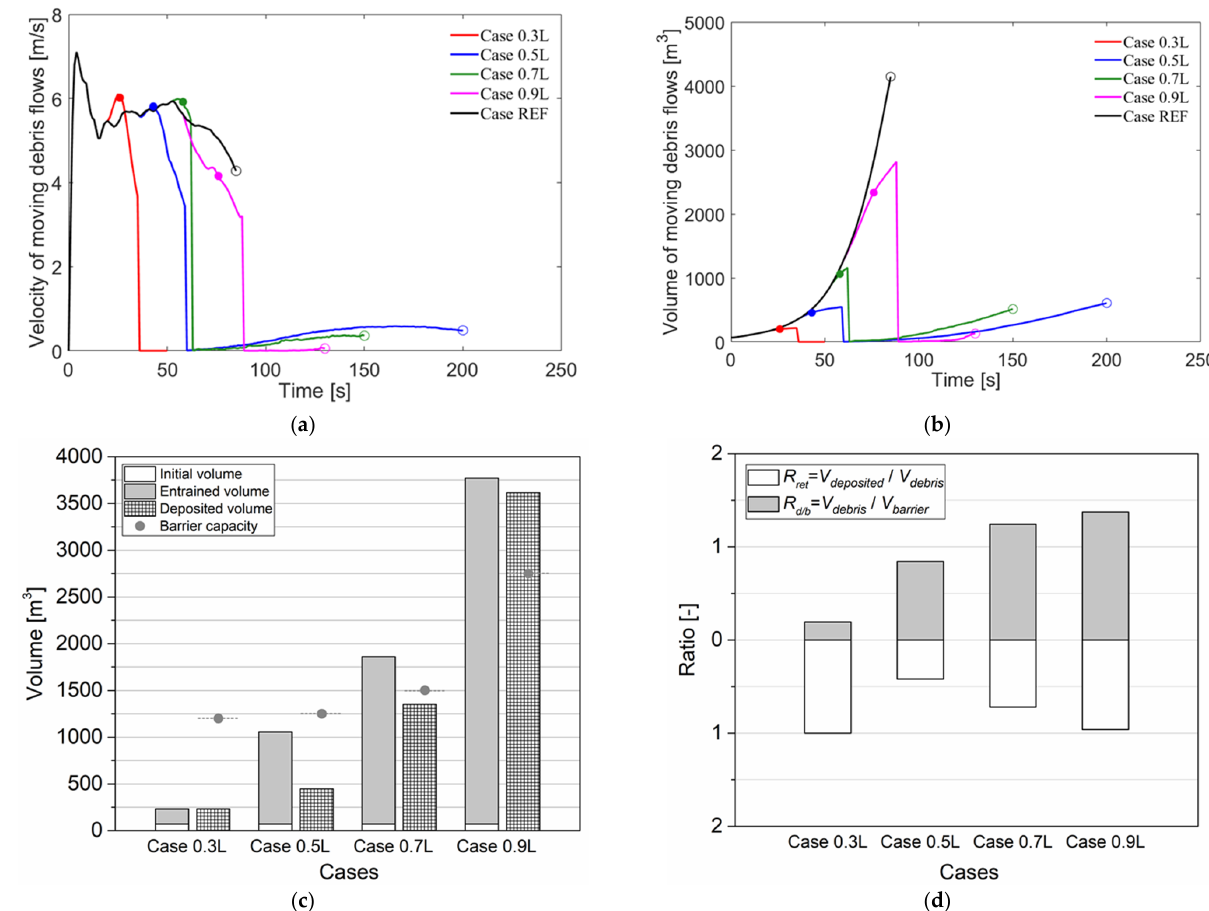
Figure 4. Effect of barrier installation on characteristics of the debris flow: ( a ) the debris-flow velocity; ( b ) the deposited volume behind the barrier; ( c ) the volumetric characteristics of debris flows with respect to barrier location and capacity; ( d ) the retained volume ratio ( R ret ) and the debris-to-barrier volume ratio ( R d/b ). Note that the filled and empty circles indicate the time when the debris flow made contact with each barrier and the village, respectively.